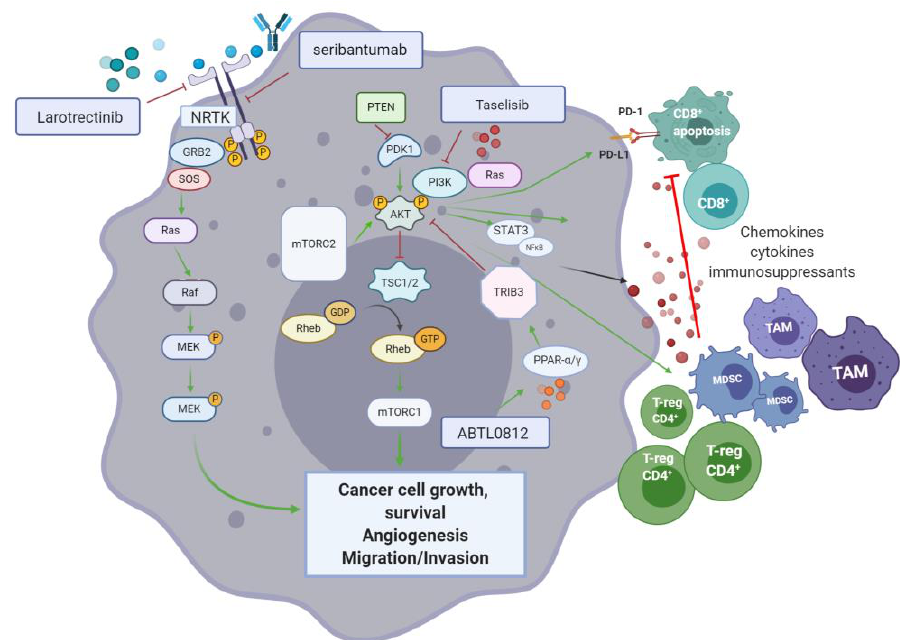
Figure 6. The PI3K/AKT/mTOR pathway in pancreatic cancer is central for cancer cell growth, survival, migration, invasion, angiogenesis, and modulation of the anti-cancer immune response. Inhibition of different elements of this signalling pathway is shown to reduce disease progression and promote CD8 + T-cell infiltration in pancreatic ductal adenocarcinoma (PDAC).